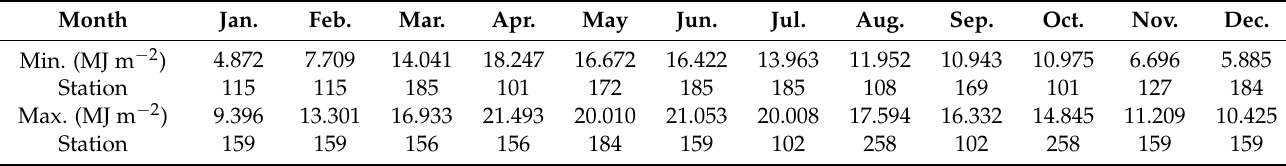
Figure 14. The distribution of monthly mean daily SSI, from 1 January 2020 to 31 December 2021, observed from KMA ASOS stations in ( a ) January, ( b ) February, ( c ) March, ( d ) April, ( e ) May, ( f ) June, ( g ) July, ( h ) August, ( i ) September, ( j ) October, ( k ) November, and ( l ) December. Table 4. Minimum and maximum values of monthly mean daily KMA ASOS in situ SSI from 1 January 2020 to 31 December 2021, where Min. and Max. indicate minimum value and maximum values, respectively.